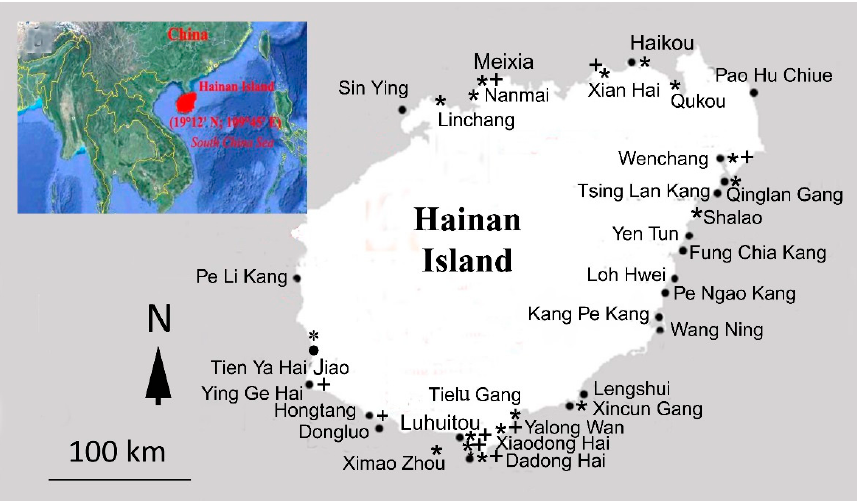
Figure 1. Algal collection sites at Hainan Island: ( )—collection sites of Tseng and coworkers in the 1930s–1980s (old spellings of sites names); ( )—collection sites of two German-Chinese expeditions during October–December 1990 and March–April 1992; ( )—collection sites of